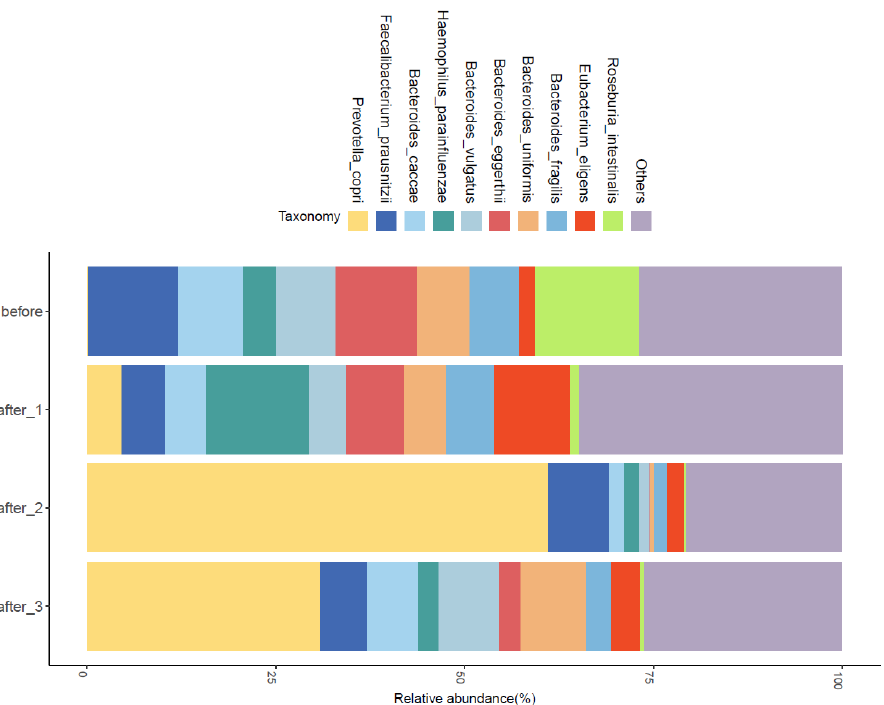
Figure 1. Changes in the abundance of the Top10 species-level bacteria before and after FMT. Before refers to before FMT, after_1 refers to after taking the first enterobacterial capsule, after_2 refers to after FMT completion, after_3 refers to one month after FMT completion.